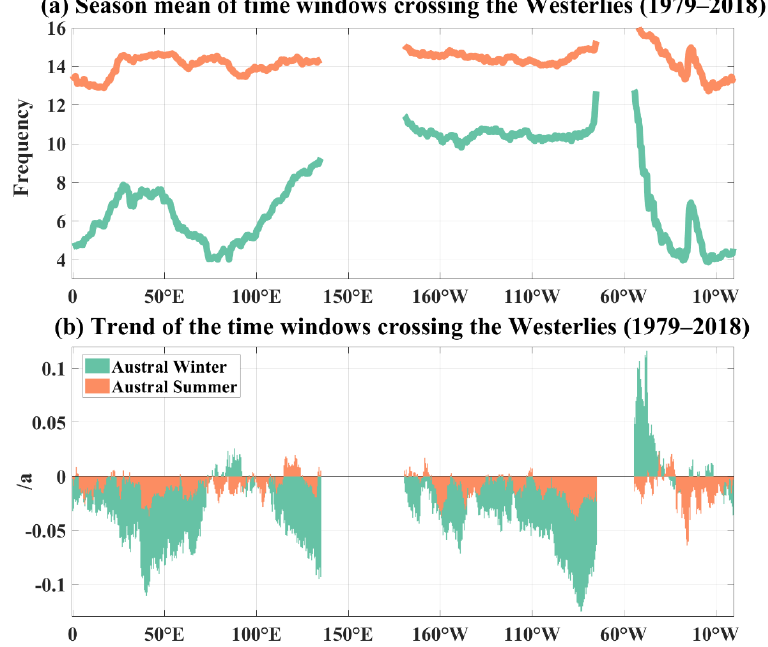
Figure 6. Season mean ( a ) and its trend ( b ) for the time windows for crossing the westerlies during 1979–2018.